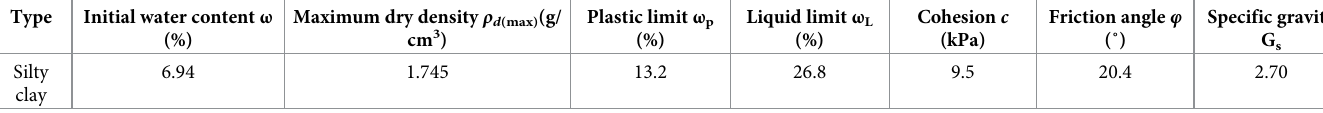
Table 1. Physical parameters of the test